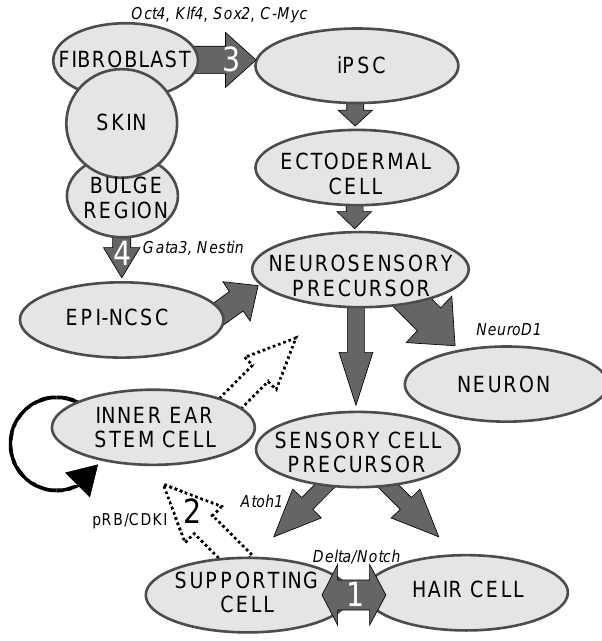
Figure 1. Four methods of regenerating hair